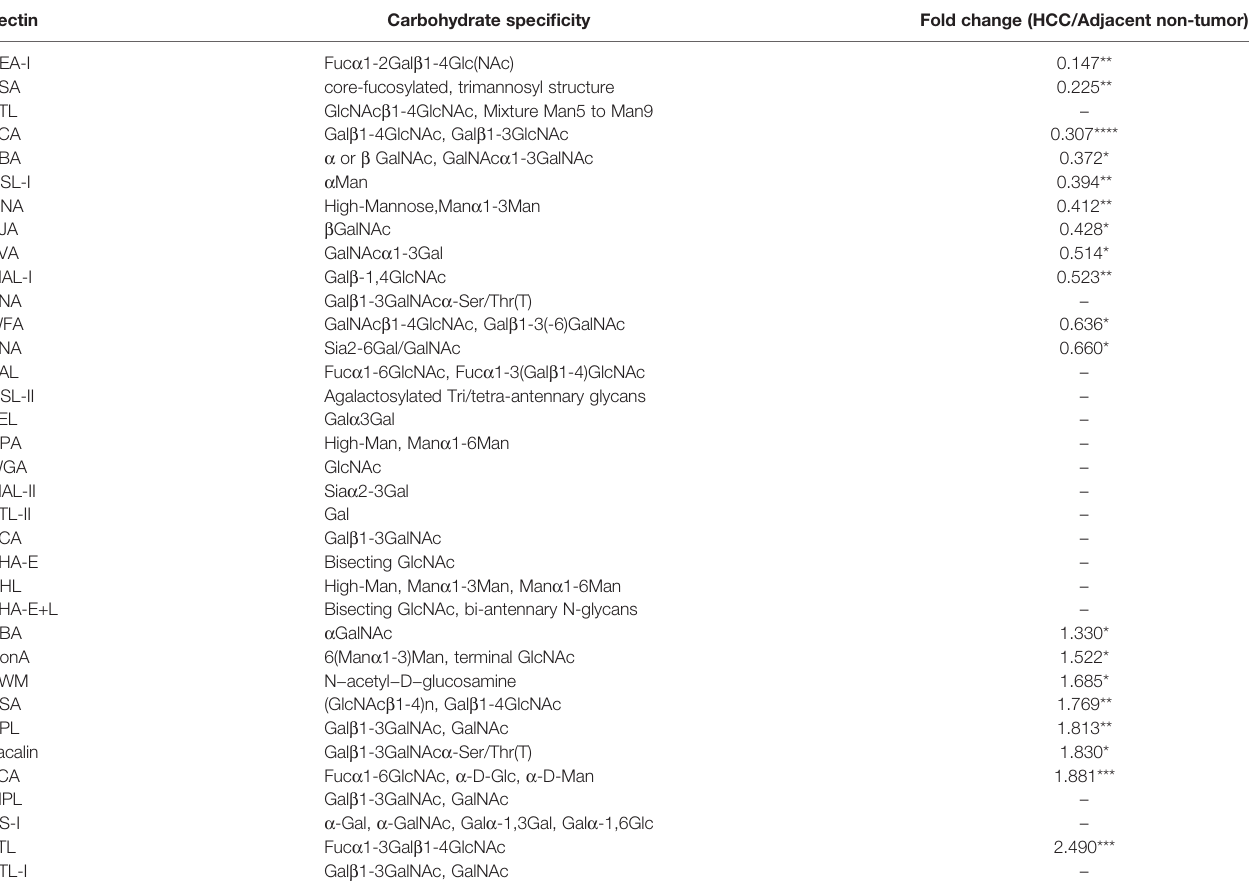
TABLE 3 | Lectin binding glycopatterns of membrane glycoproteins between HCC tissues and adjacent non-tumor tissues. Lectin